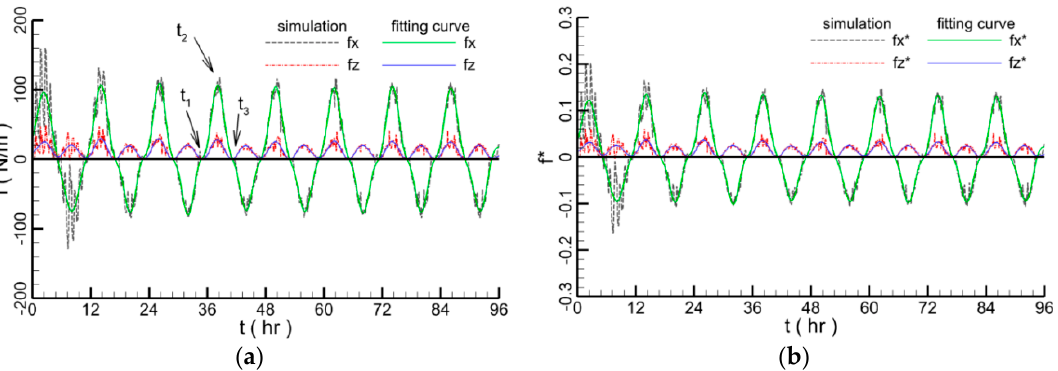
Figure 13. The hydrodynamic force of submarine pipeline. ( a ) Maximum force. ( b ) Non-dimensional maximum force.